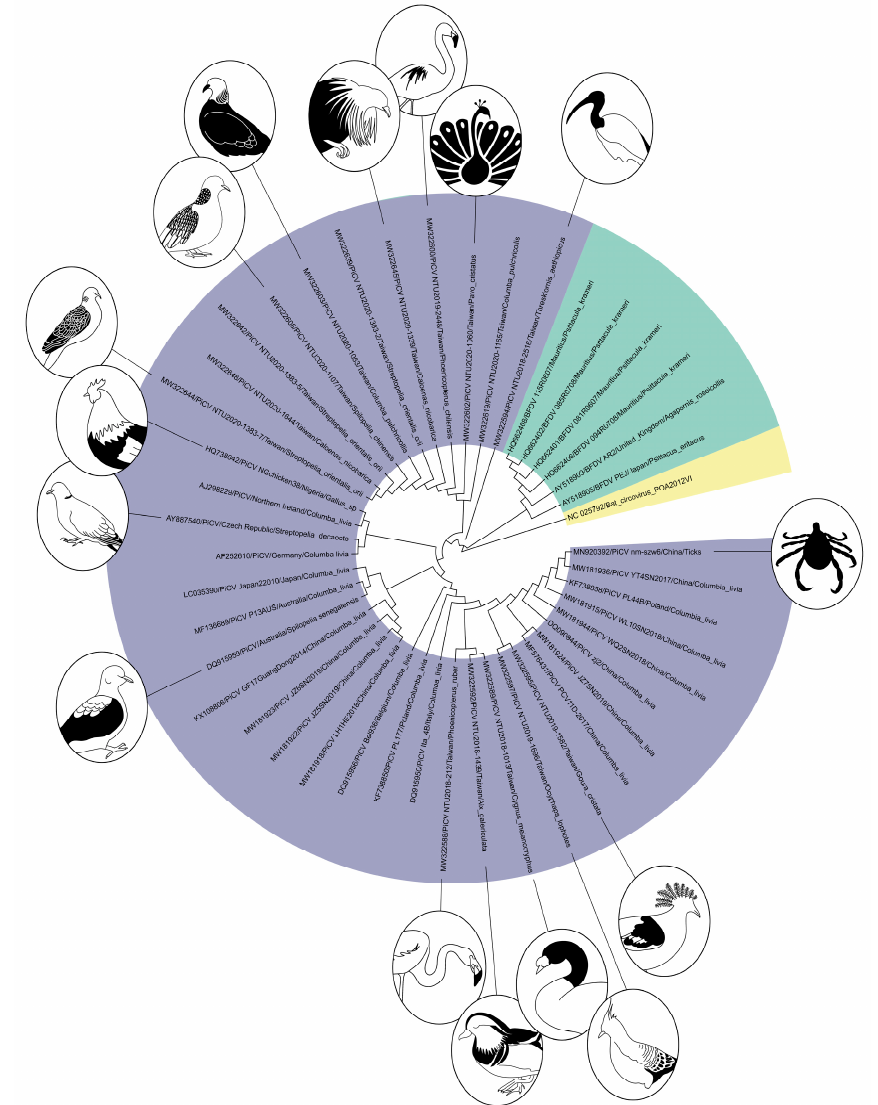
Figure 6. A neighbor-joining tree depicting the relationship among PiCV sequences from various hosts. Using the 371 available PiCV whole genome sequences retrieved from NCBI, a pair- wise identity calculation showed that the two sequences with the lowest identity similarity (83.201%) are sequences from Japan (Accession Number LC035390) and China (Accession Number KJ704801), which is consistent with the study of Khalifeh et al. (2021) that reported >83% genome-wide identity [73] (Supplementary Figure S1 and Supplementary Table